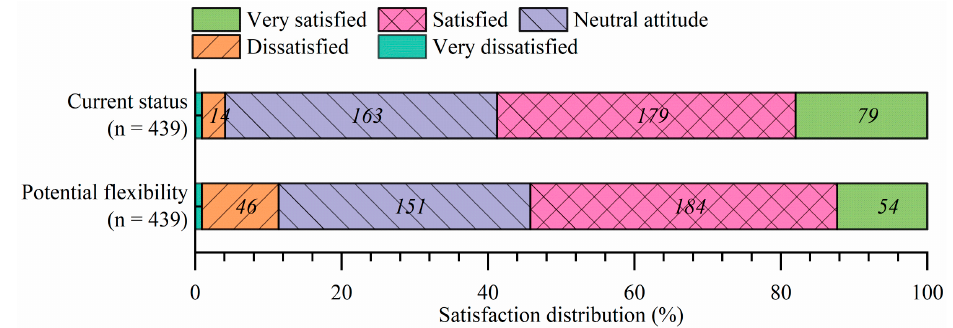
Figure 2. Satisfaction on the current status and potential flexibility of housing.